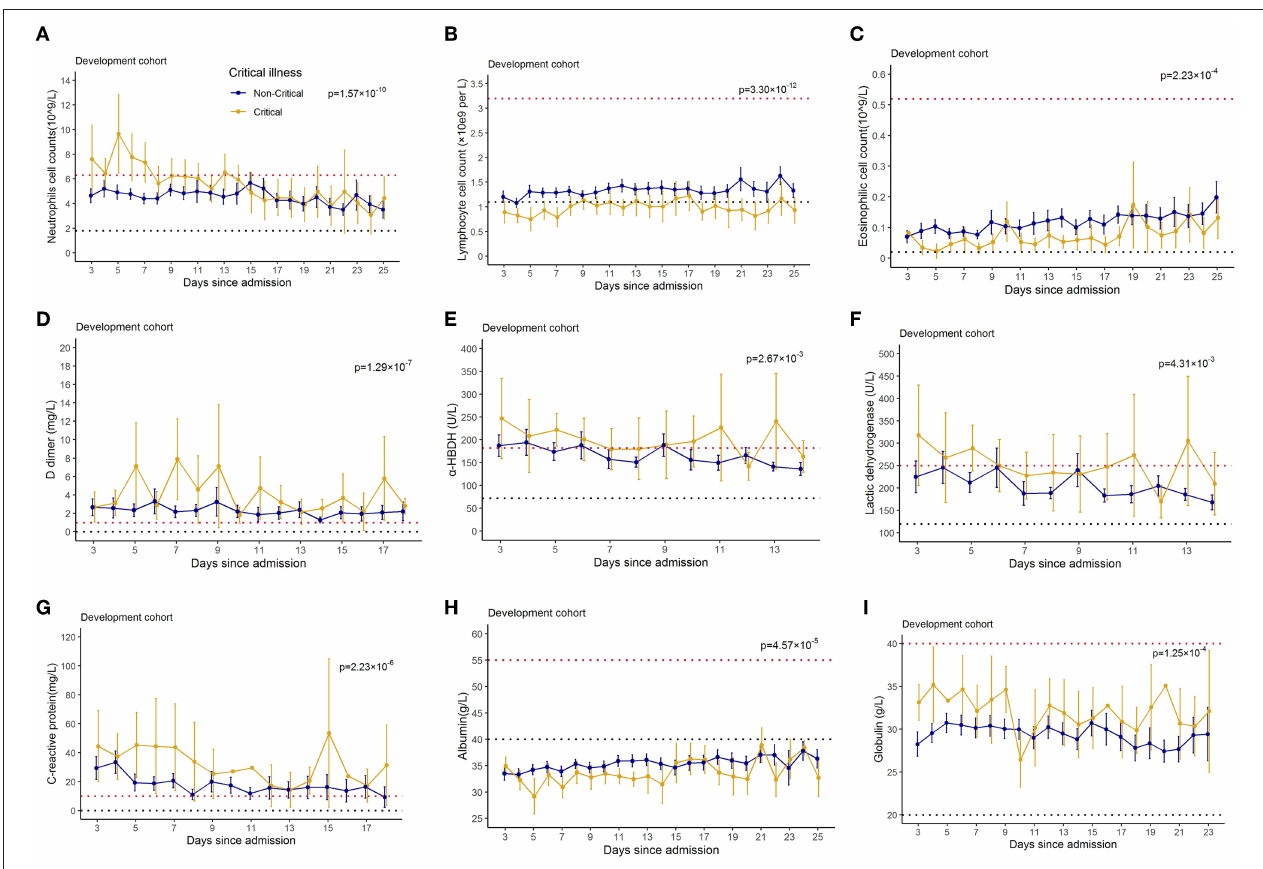
FIGURE 3 | Temporal changes in laboratory findings from illness onset in patients hospitalized with COVID-19. Temporal changes in neutrophils (A) , lymphocytes (B) , eosinophils (C) , D-dimer (D) , alpha hydroxybutyrate dehydrogenase (E) , lactate dehydrogenase (F) , C-reaction protein (G) , albumin (H) , and glucose (I) in the development dataset were presented. Differences between critical illness patients and non-critical illness patients were demonstrated with p -values calculated with mixed linear models. The dashed lines in black and red color show the lower and upper normal limits of each laboratory